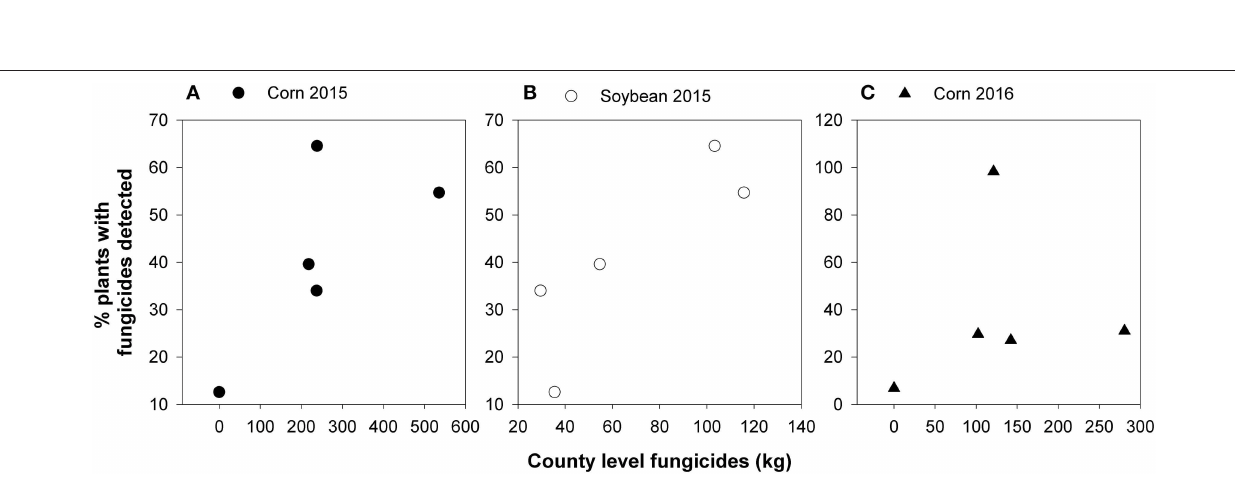
Frontiers in Ecology and Evolution |